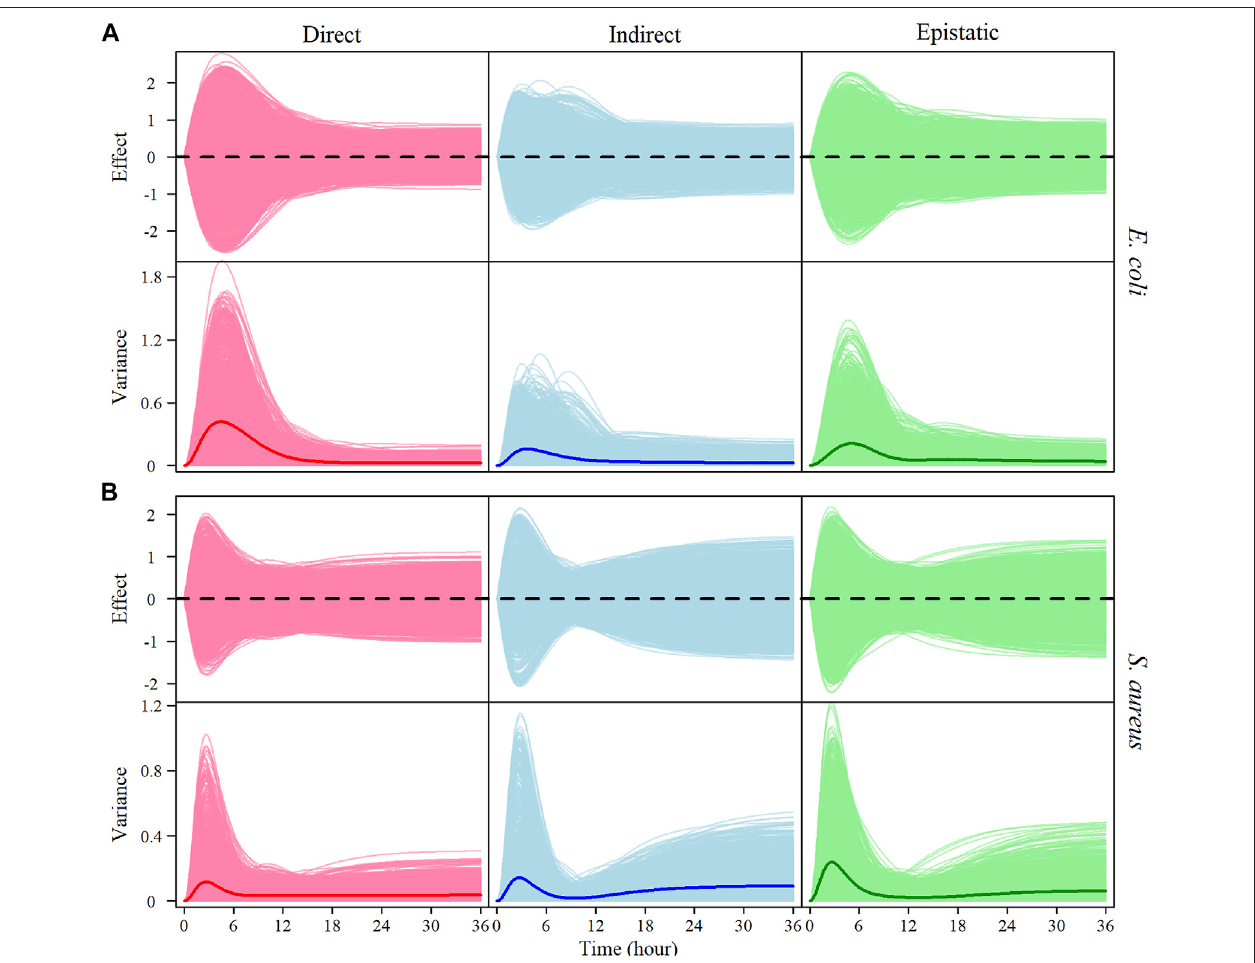
FIGURE5| Thegenotypicvalueofeachgenotypecombinationispartitionedintoitsdirect(red),indirect(blue),andgenome – genome(G – G)epistaticeffects(green) onthegrowth,withthetime-varyinggeneticvarianceexplainedbyeachoftheseeffectsof E.coli (A) and S.aureus (B) inco-culture.Thethicklinesonthevariancecurves represent the average variance of direct, indirect, and epistatic effects, respectively.